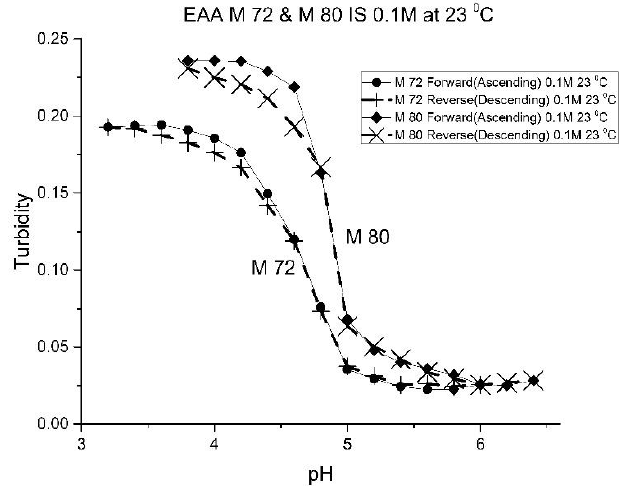
Figure 7. Ascending and descending pH profiles for polymer particles of M-64 at 23 °C and 37 °C. Solid line = ascending pH profile. Dashed line = descending pH profile.